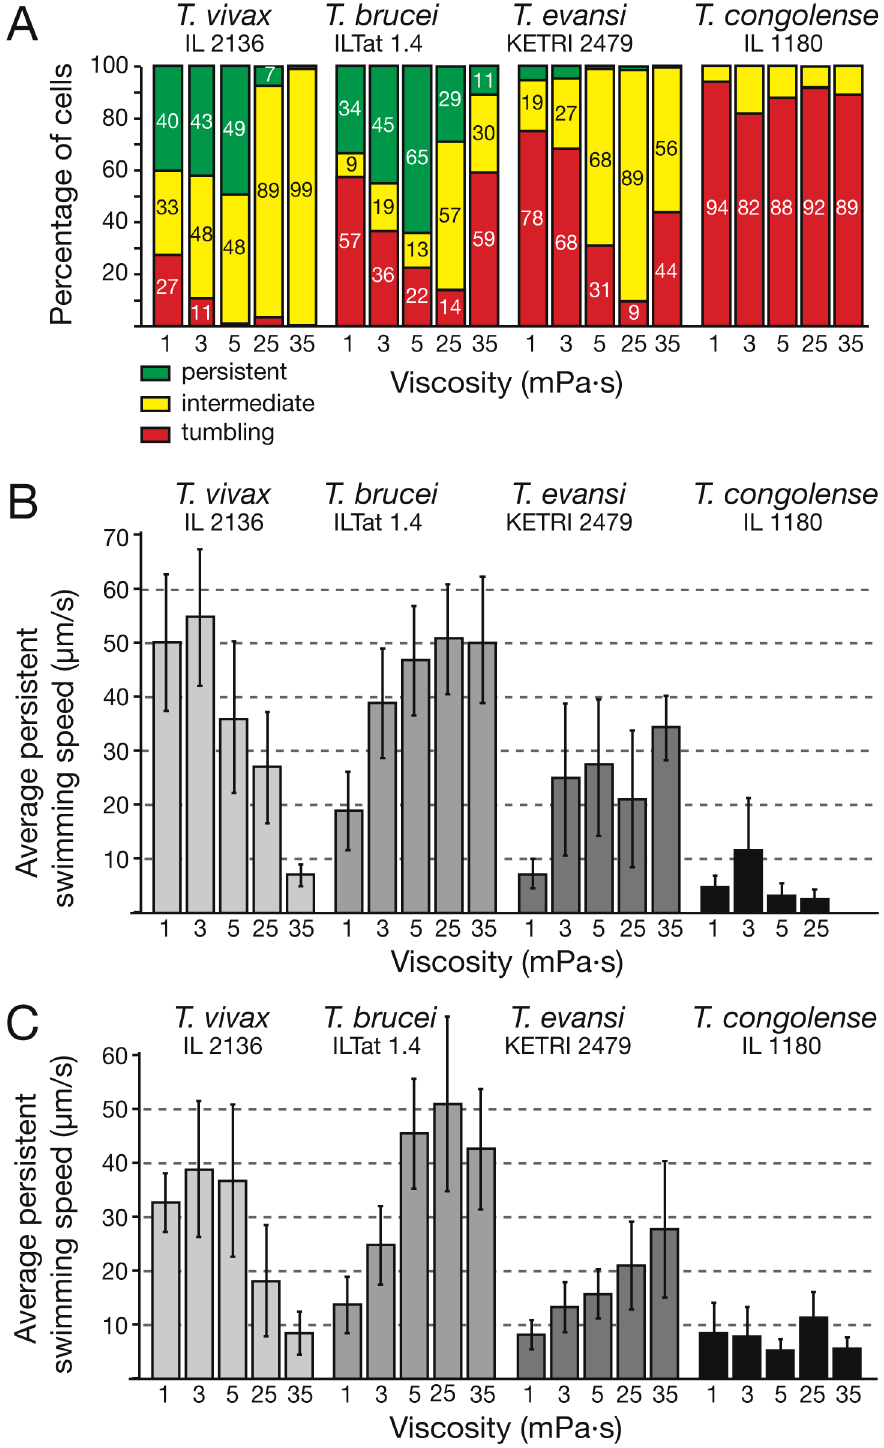
Fig 7. Trypanosomes show species-specific changes in motile behaviour in response to viscosity changes. A) The effect of viscosity on the proportion of swimming trypanosomes. The parasites were isolated from infected mice and resuspended in fresh trypanosome dilution buffer (TDB) in the absence or presence of methylcellulose (0.2, 0.4, 0.6 and 0.8%), generating medium viscosities between 1 mPa (cid:3) s (TDB) and 35 mPa (cid:3) s (0.8% methylcellulose). For each condition the trajectories of 300 parasites were analysed. B)